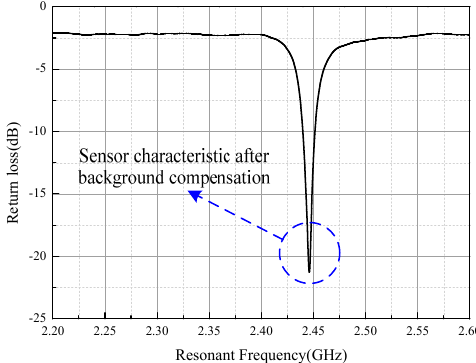
Figure 10. Received signal after compensation in the frequency domain.